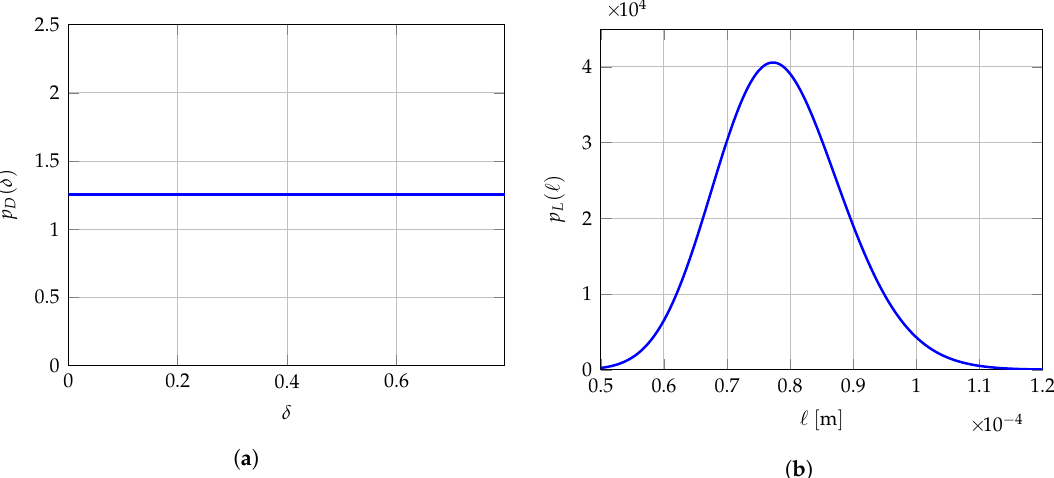
Figure 8. Fixed-point iterative algorithm: probability density functions p D and p L of random variables D and L , respectively. ( a ) p D ( δ ) ; ( b ) p L ( (cid:96) )